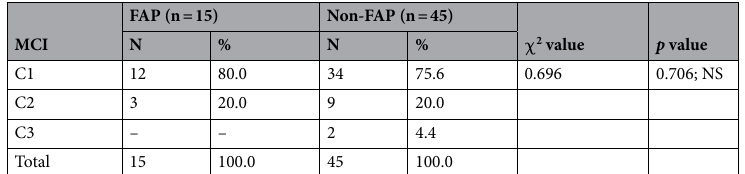
FAP (n = 15) Non-FAP (n = 45) MCI